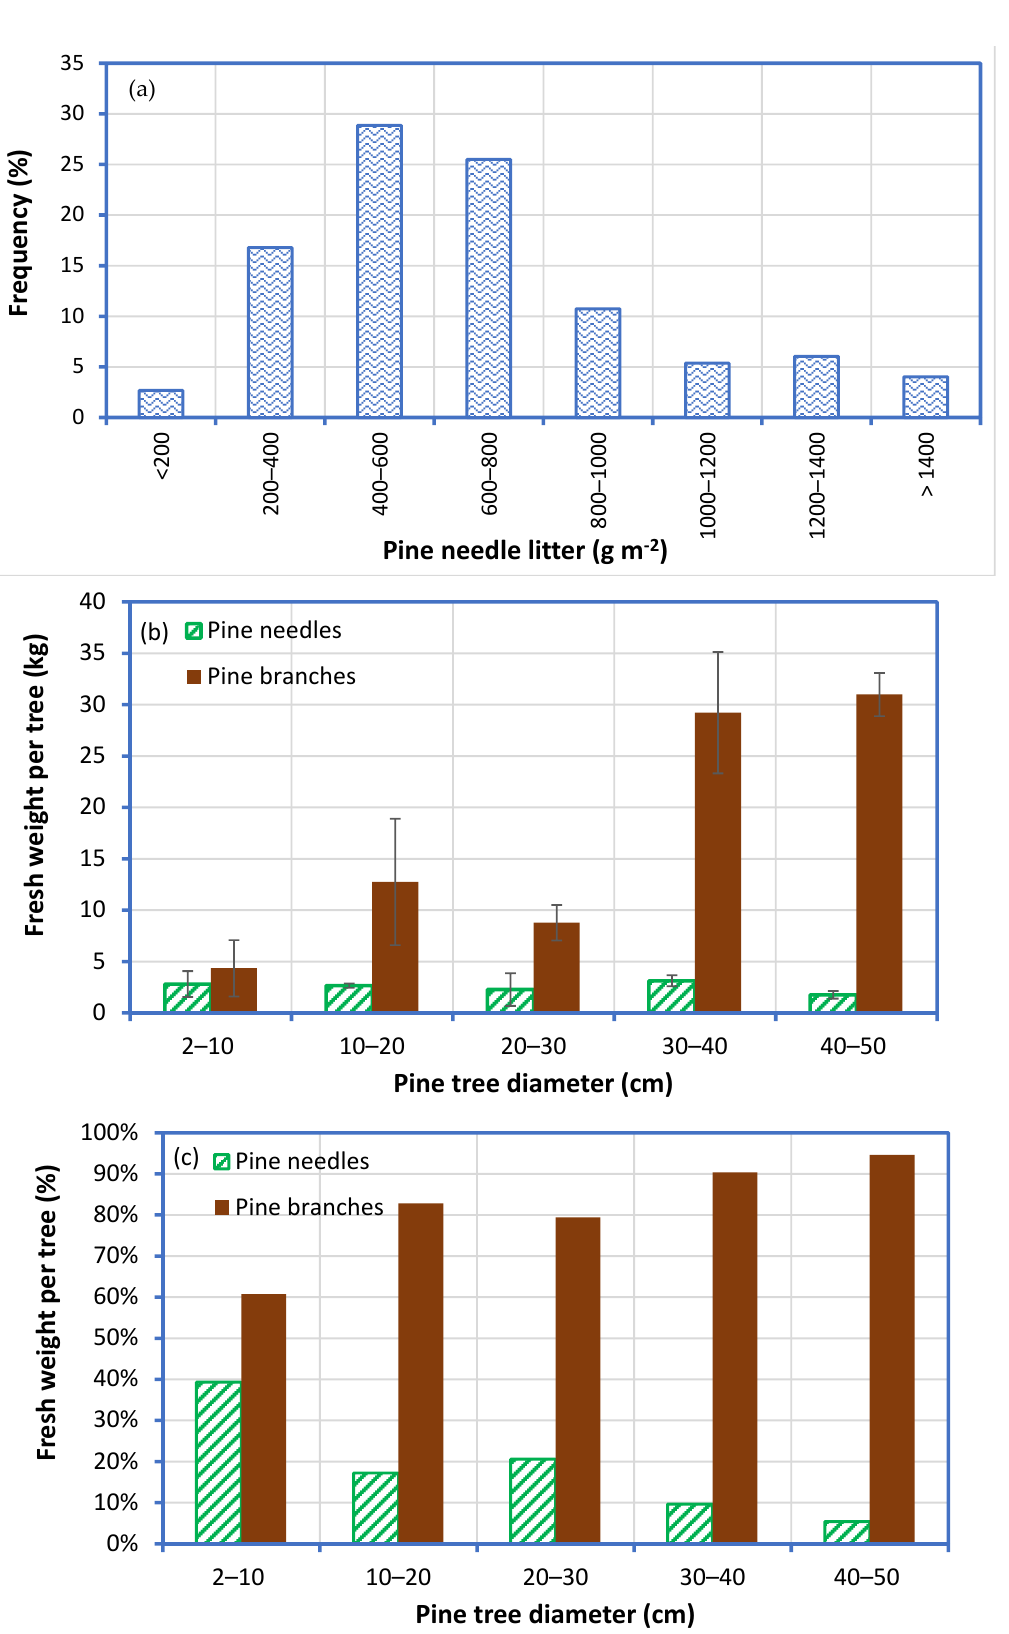
Figure 3. ( a ) Distribution of pine needle litter quantity accumulated on the forest floor and ( b , c ) quantity of fresh pine needles and branches collected from different diameter trees during tree pruning up to 3 m above ground (in kg of fresh matter ( b ) and as percentage ( c )). Table 1. Physicochemical properties of fresh pine needles from different diameter trees, pine nee- dle litter, pine branches, and pine bark.